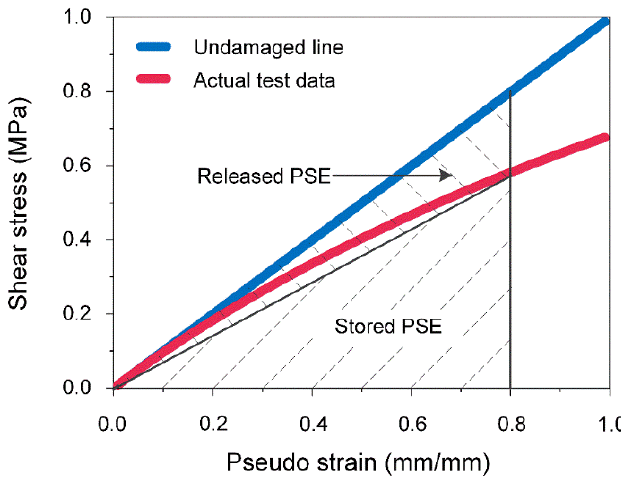
Figure 1. Definition of pseudo strain energy.